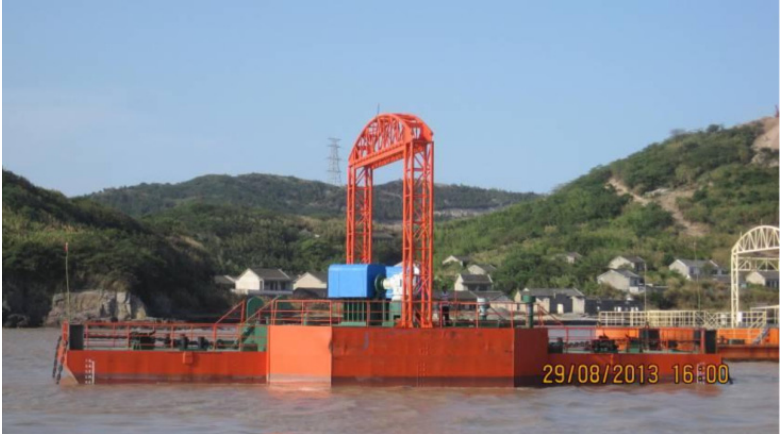
Figure 8. “Haineng II”—2×300 kW floating vertical-axis TCPGS. Reproduced from